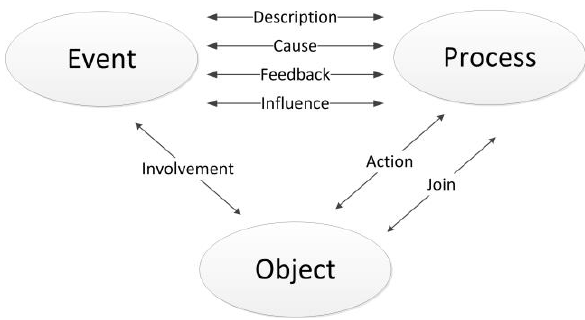
Figure 3. Semantic interaction relationship between Object- Event- Process